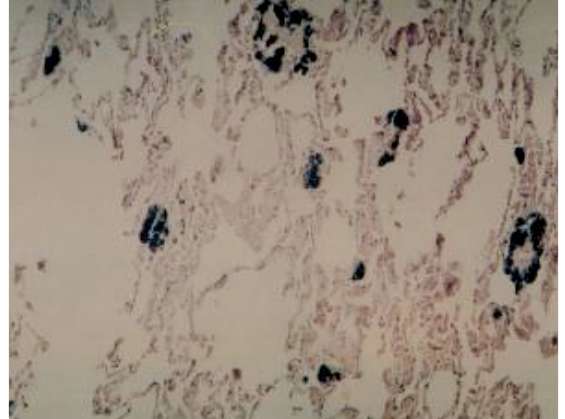
Image 13. Lung of Gayal showing granuloma and deposition of carbon particles, Anthracosis, H&E, 87.5x.